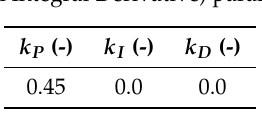
Table 6. PID (Proportional Integral Derivative) parameters for the